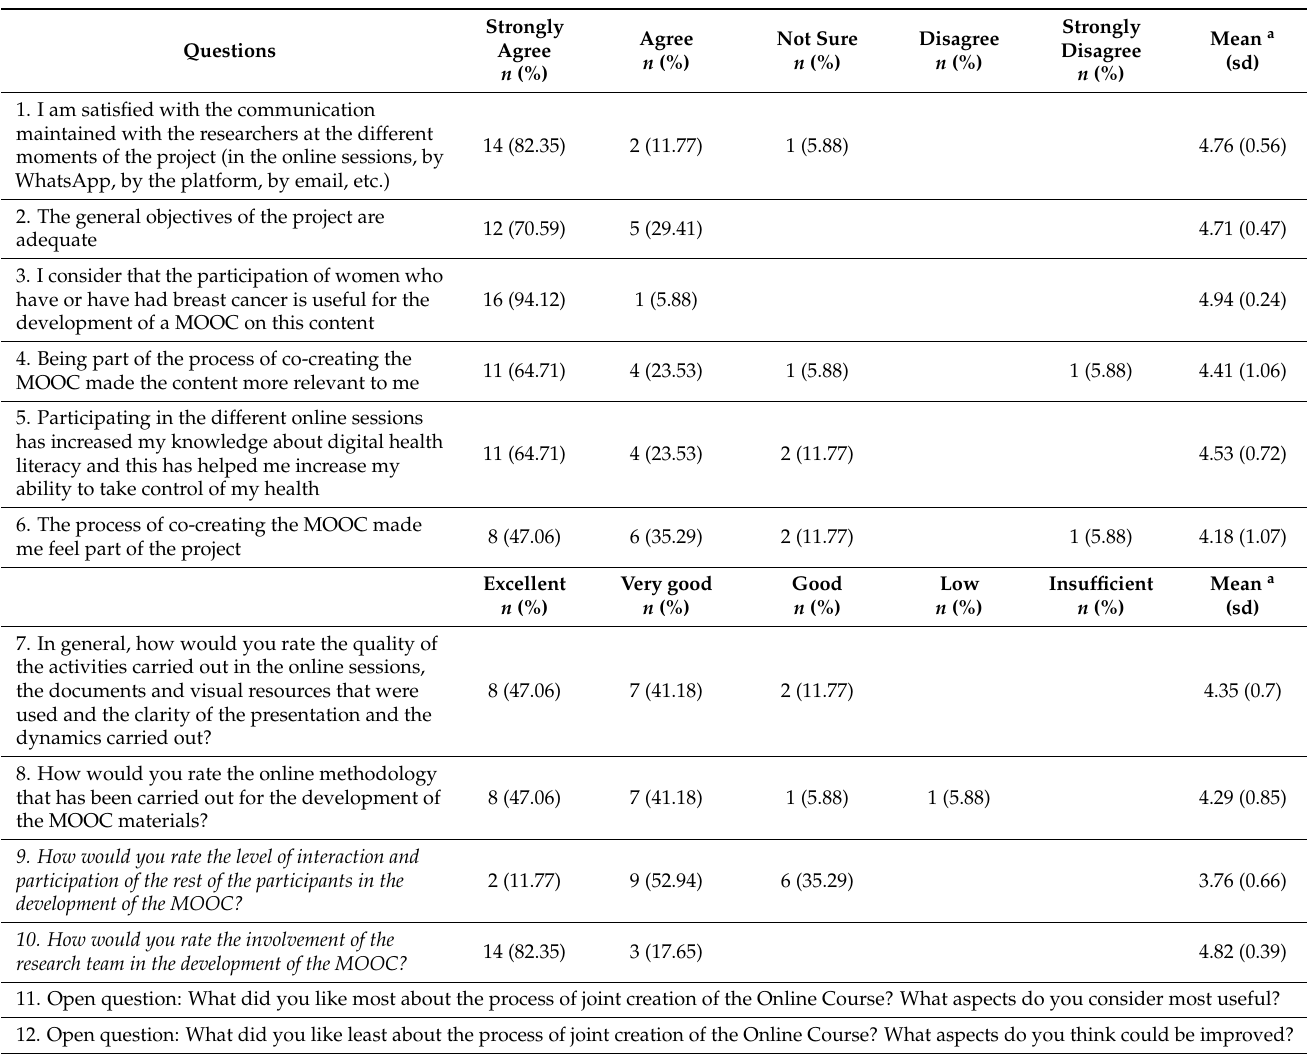
Table 3. Experience in the co-creation